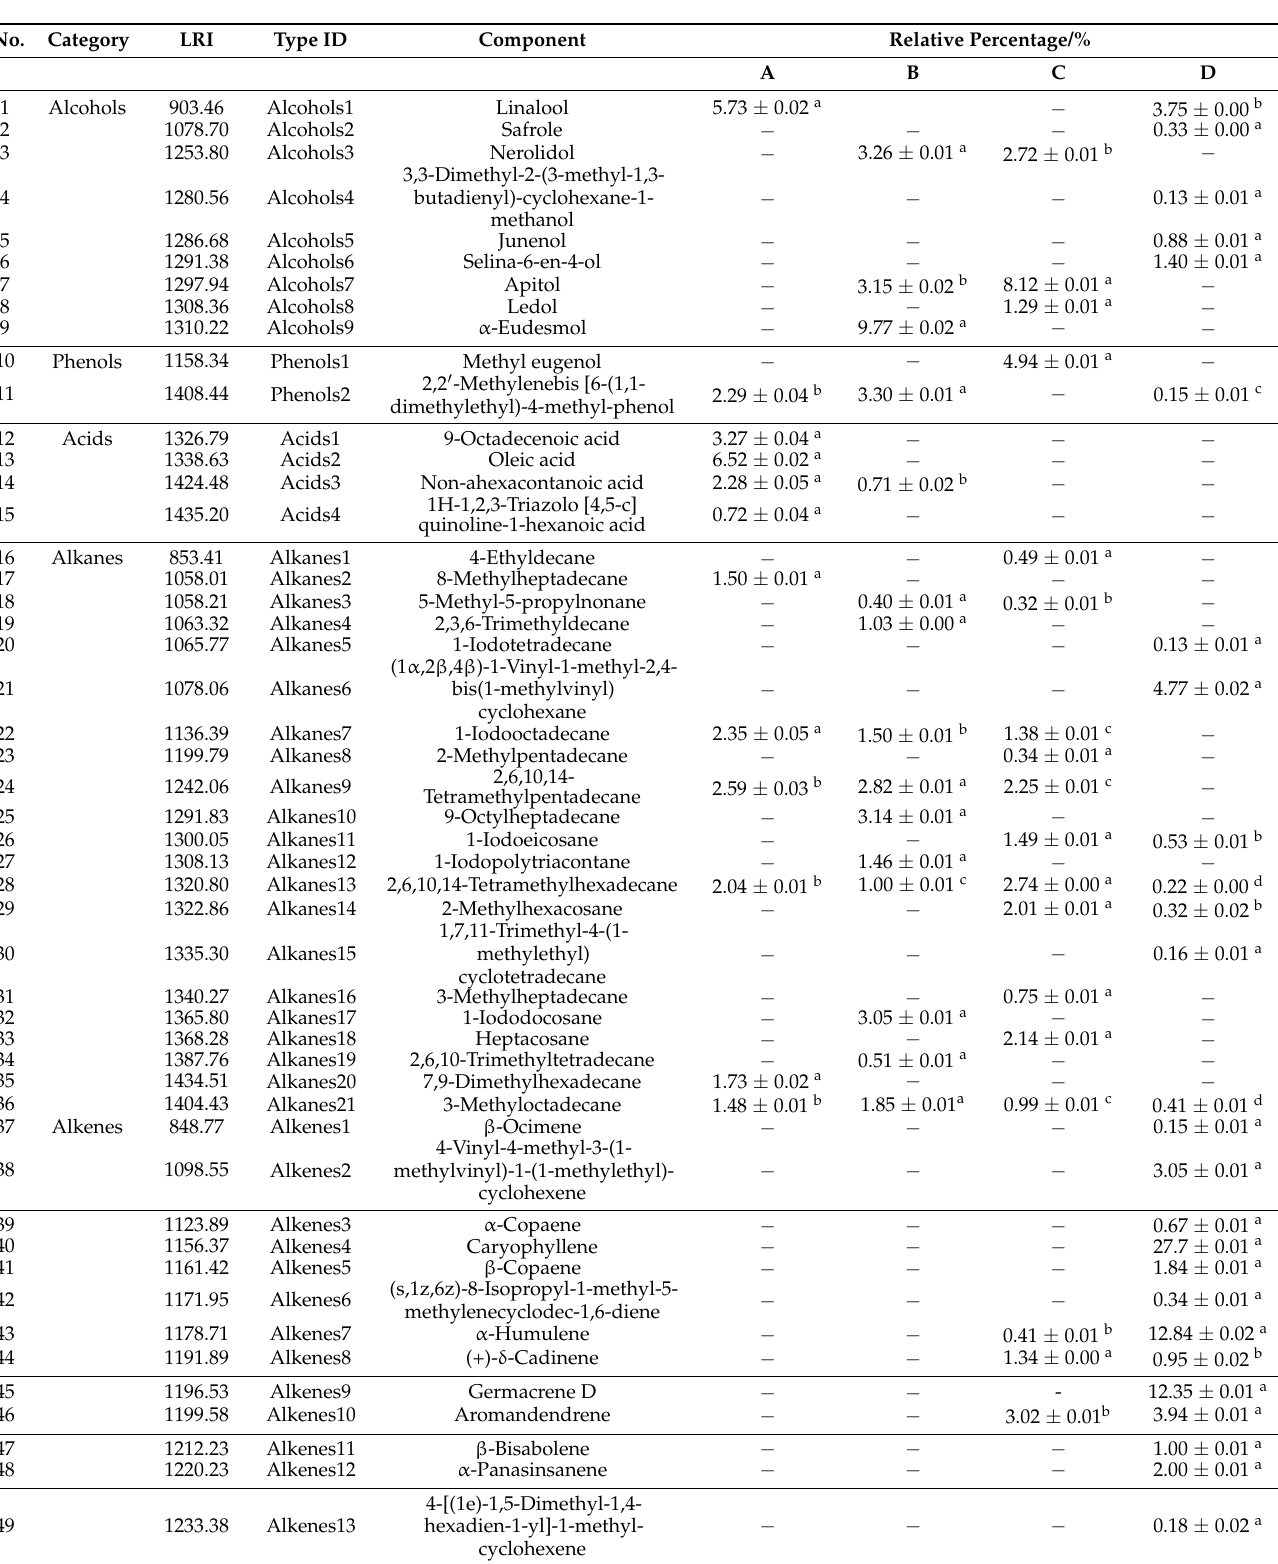
Table 1. Main aromatic components of cabya essential oil and their relative contents at each